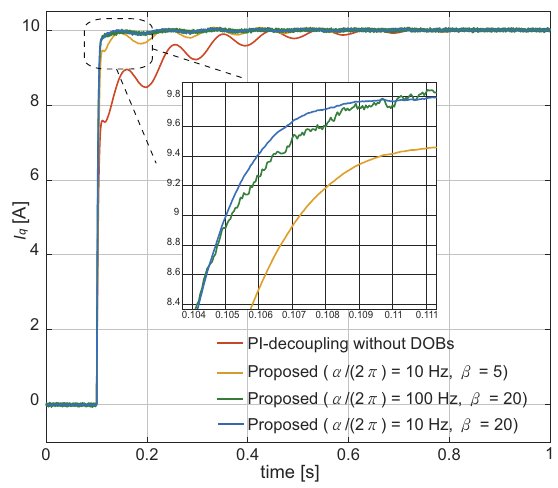
Figure 6. The q -axis current ( i q ( t ) ) step responses under parameter variations.